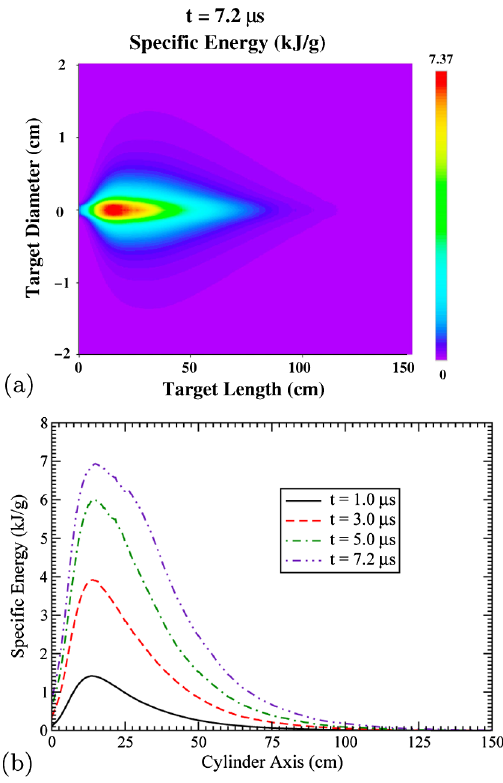
FIG. 12. (a) Temperature distribution in the cylindrical copper target, r ¼ 5 cm , L ¼ 1 : 5 m , irradiated by the 440 GeV SPS proton beam with (cid:1) ¼ 0 : 5 mm at t ¼ 7 : 2 (cid:2) s (end of the beam) and (b) temperature profiles along the axis at different